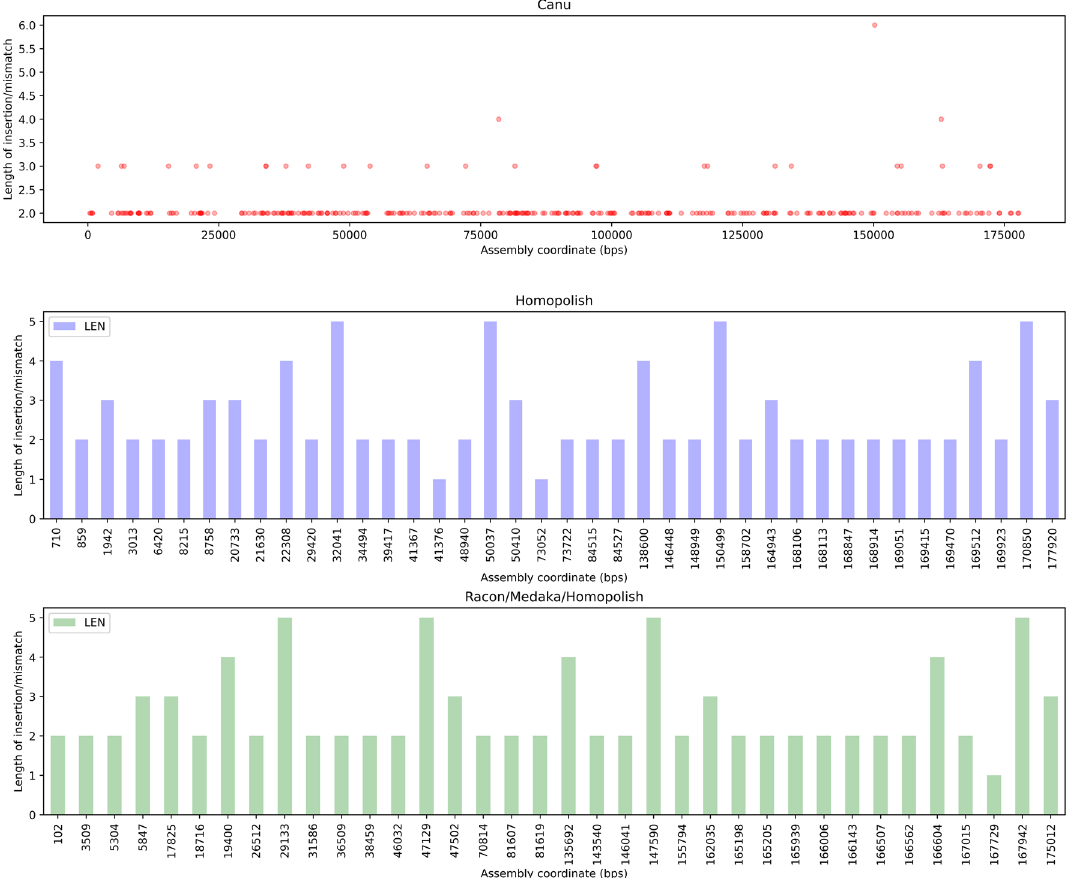
Figure 8. Scatterplot/Barplots showing Effect of polishing using Homopolish (occurrences of polymer of length < 10